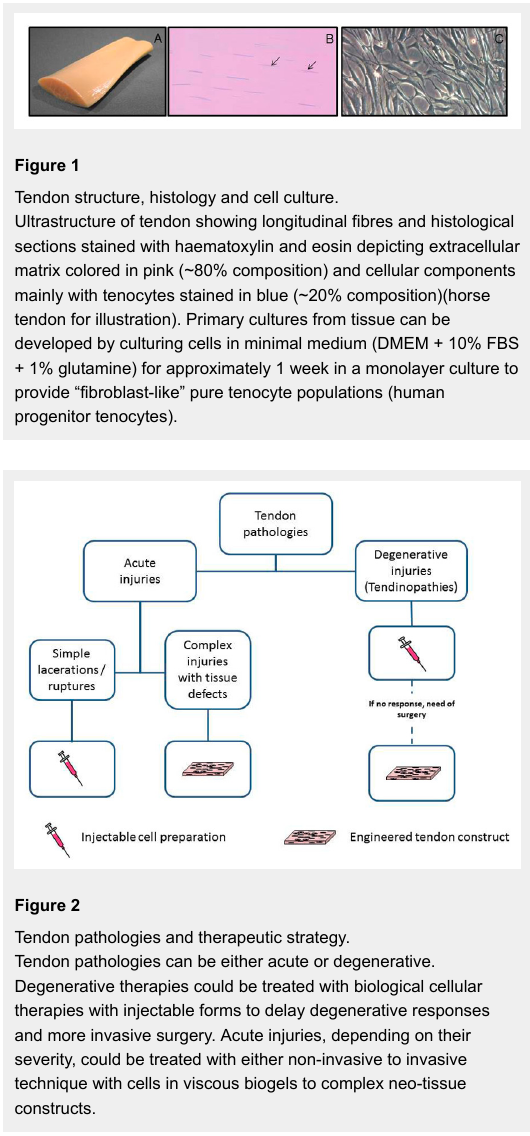
and ligaments that can frequently occur with hand overuse, degenerative diseases and aging. These can promote joint instability and arthritis and eventually may require surgical